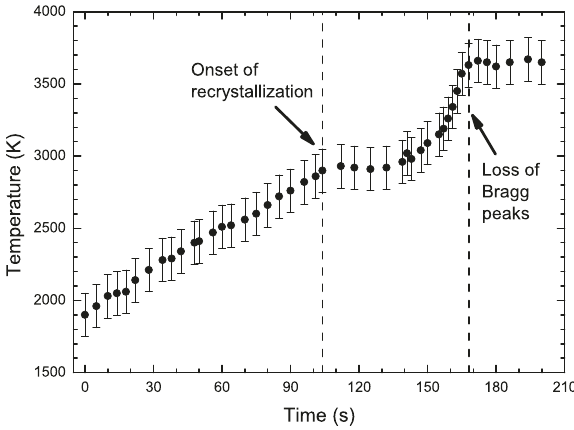
Fig. 2 The Nb temperature measured as a function of time at 50 GPa. The vertical lines indicate the beginning of the two